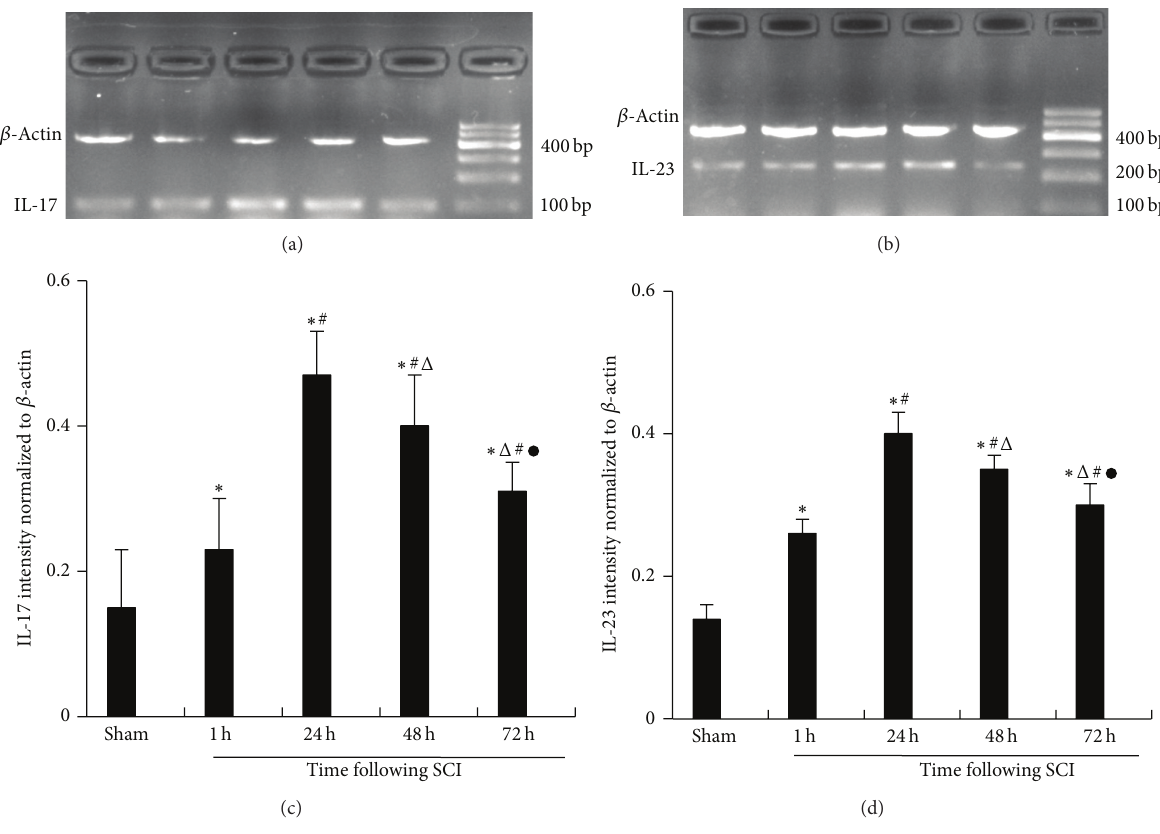
Figure 5: (a) and (b): IL-17 and IL-23p19 mRNA transcription in spleen tissue. Representative images showed semiquantitative RT-PCR for IL-17 and IL-23p19 transcription sham. The sham-operated group; 1 h. The 1 h group of SCI; 24 h. The 24 h group of SCI; 48h. The 48 h group of SCI; 72 h. The 72 h group of SCI. (c) and (d): densitometric quantification of IL-17 and IL-23p19mRNA expression in spleen tissues. Densitometric quantification of PCR bands showed that, among the IL-17 and IL-23p19, the sham-operated group, 1h group of SCI, 24 h group of SCI, 48 h group of SCI, and 72 h group of SCI, the mRNA expression was significantly difference between each groups and peaked at 24 h. The data are presented as the mean ± the SE. ∗ 𝑃 < 0.05 versus sham, # 𝑃 < 0.05 versus 1h, △ 𝑃 < 0.05 versus 24 h, and e 𝑃 < 0.05 versus 48